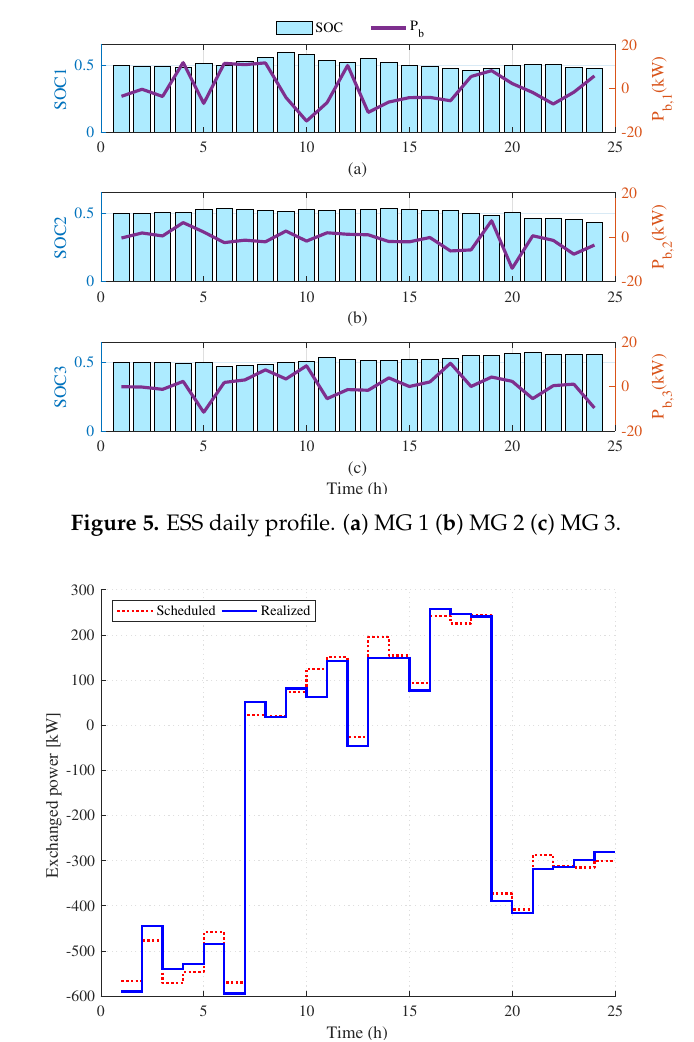
Figure 4. Local controllers structure in voltage control mode.